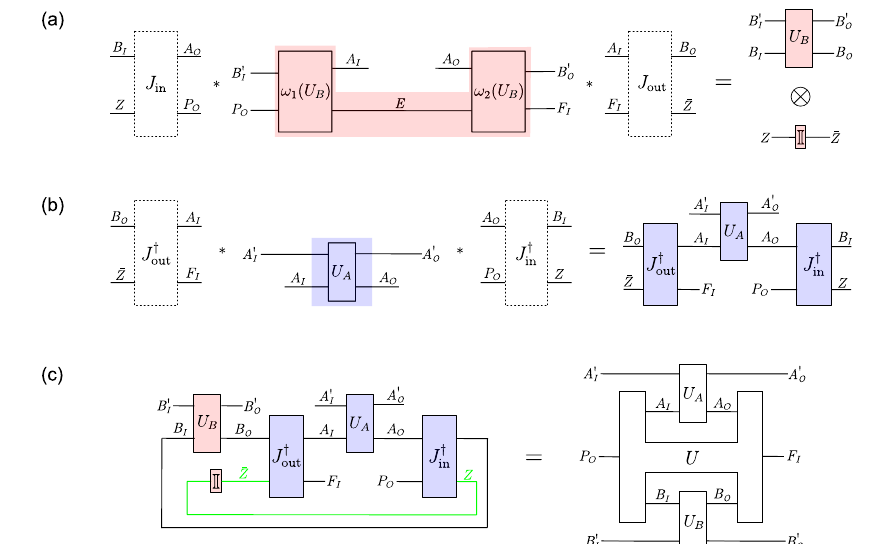
Fig. 8 | Description of the bipartite temporal circuit in terms of time- delocalised subsystems. a Description of the red circuit fragment, which imple- ments an operation from H B 0 I P O A O to H B 0 O A I F I , in terms of the time-delocalised sub- systems B I , Z of the joint system A O P O and B O , (cid:2) Z of A I F I . b Description of the blue circuitfragment, whichissimplytheoperation U A ,intermsofthe time-delocalised